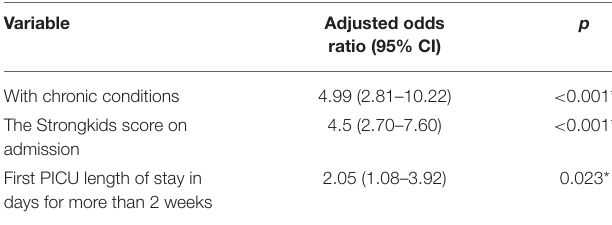
TABLE 2 | Risk factors of PICU readmission within 1 year in the multivariate